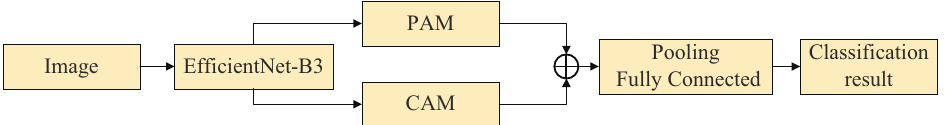
Figure 8. The structure of the